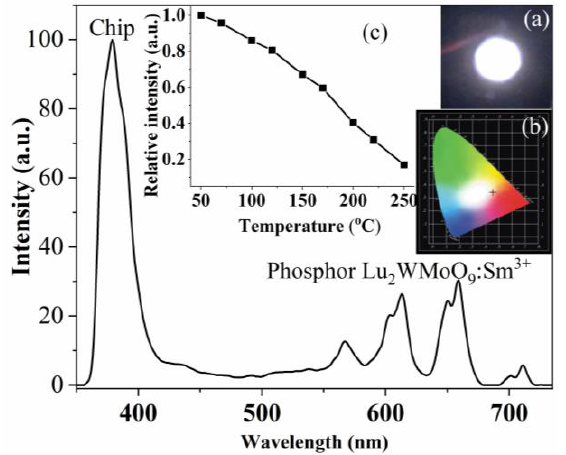
Figure 8. The emission spectrum of a packaged LED with 3 mol.% Sm 3+ (x = 0.03) doped Lu 2 MoWO 9 phosphor, insets show the lighted LED ( a ), corresponding chromaticity coordinates in CIE diagram ( b ), and temperature-dependent emission spectra of phosphor ( c ).